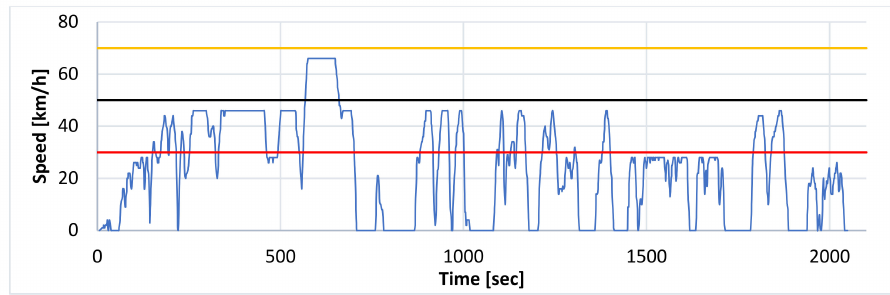
Figure 1. Speed profile for the test run in traffic and the “Normal” mode.